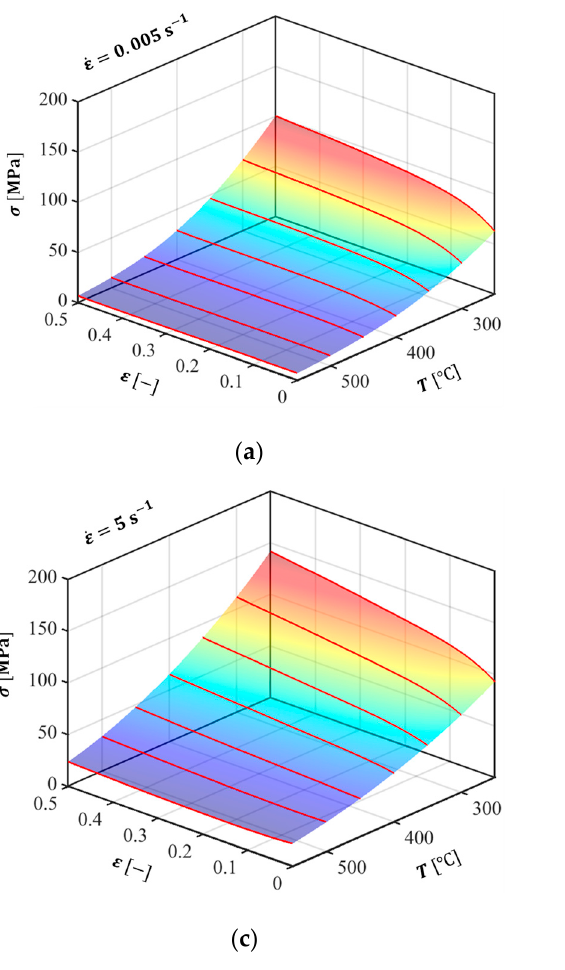
Figure 7. Flow stress responses predicted by the Arrhenius-type strain rate- and temperature-dependent strain hardening model: ( a ) 0.005 s − 1 ; ( b ) 0.5 s − 1 ; ( c ) 5 s − 1 ; and ( d ) 50 s − 1 . The red lines represent the flow stress curves used in the FE analysis.